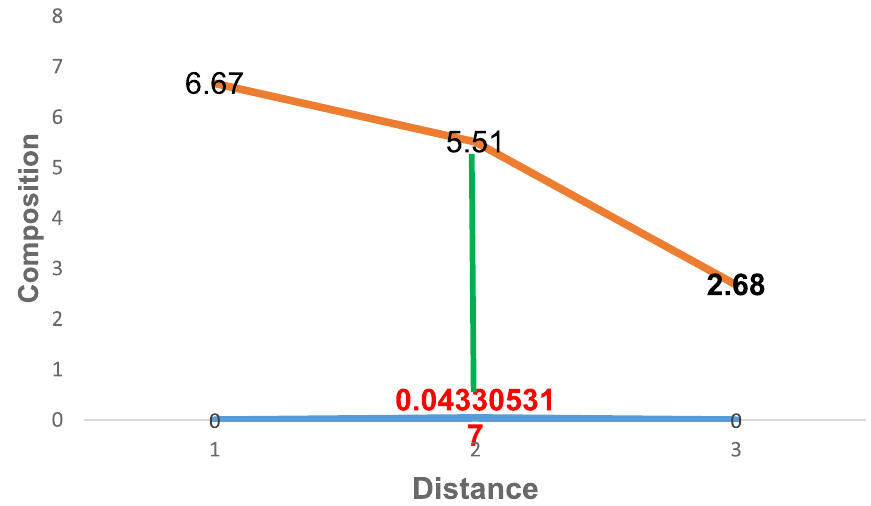
Figure 6. Diffusion of carbon atoms into the surface of grey cast iron at 900° for 180 min.